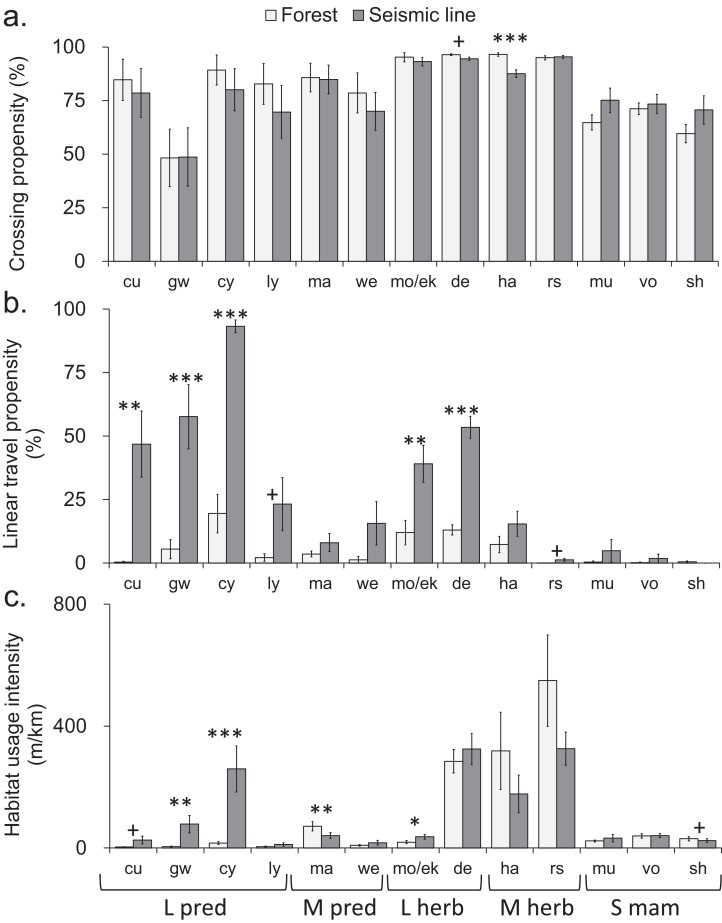
Comparison of mammal crosswise movement, linear movement and habitat use, between seismic line clearings and forest habitat for different species.Comparison of mammal movement and habitat use between seismic line (SL) clearings and forest habitat for different species. (A) Crossing propensity (% of transect approaches which fully crossed), (B) linear travel propensity (% of track length which was linear along the transect), (C) habitat usage intensity (total on transect track extent). Species are ordered by body size-diet group (see Table 1 for abbreviations): large predator (L pred), mid-sized predator (M pred), large herbivore (L herb), mid-sized herbivore (M herb), small mammal (S mam). Values are means and standard errors (n = 14 paired transects per habitat), with results declared significant by Benjamini-Hochberg (BH) procedure and paired t-test P-values (unadjusted, *P < 0.05, **P < 0.01, ***P < 0.001). Results declared non-significant by BH procedure and unadjusted P < 0.1 indicated by + (Tables S8–S10).